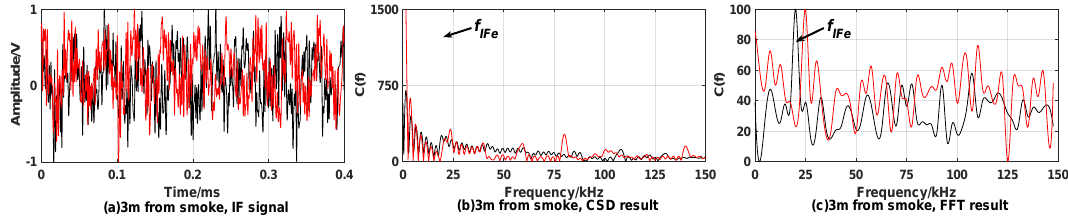
Figure 5. Simulation results when expected distance is 3 m with smoke interference but no target. When fuze is 3 m away from smoke, ( a ) is time domain waveform of the IF signal; ( b ) is the processing result of the CSD algorithm; ( c ) is the processing result of the FFT